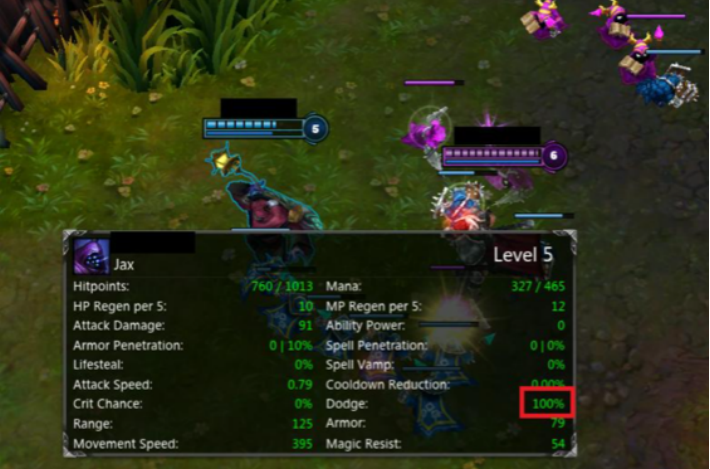
Figure 4. League of Legends game. Image taken from Reddit forum post by IoNJohn. https: //www.reddit.com/r/leagueoflegends/comments/13jlxo/why_is_this_still_here/, accessed on